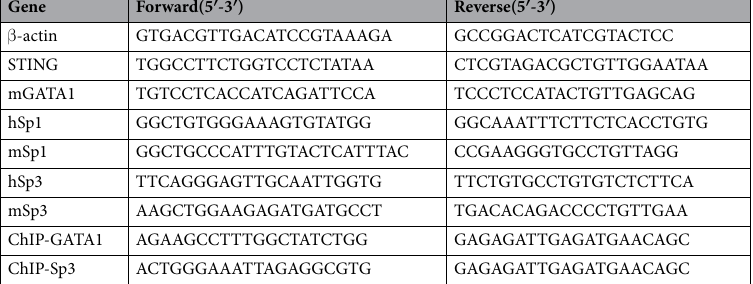
Table 2. Sequences of oligonucleotides used in RT-PCR and ChIP